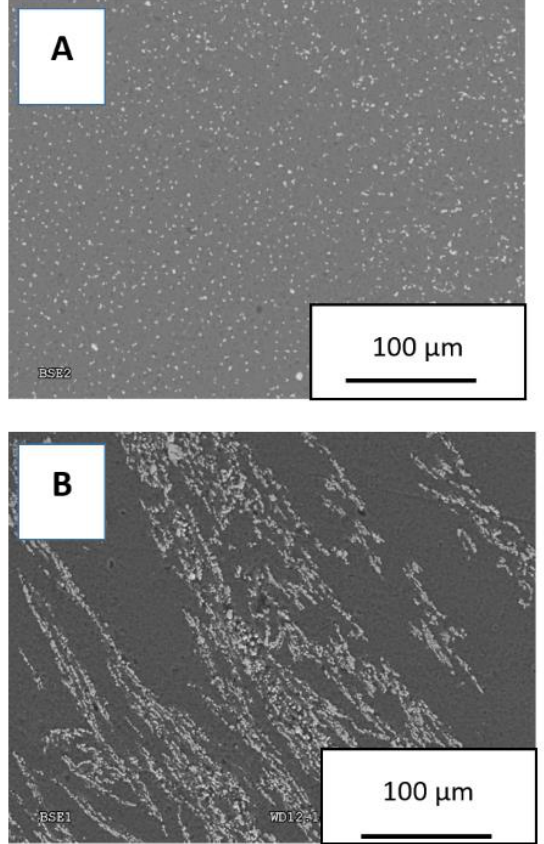
Figure 3. SEM images of Al 2 O 3 -Ni graded composites, graded concentration of Ni particles obtained by slip casting method with use of magnet: ( A ) top of sample, random distribution of Ni particles; ( B ) bottom of the sample where the magnet was, with Ni particles close to each other and chain patterns are visible. Source: results obtained under supervision of K. Konopka.